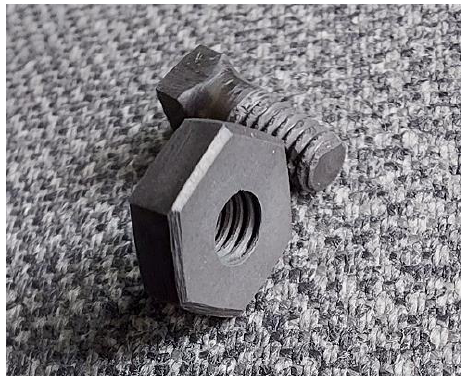
Figure 11. M3 nut and screw produced from the TiB 2 -BN-C ceramic sample.